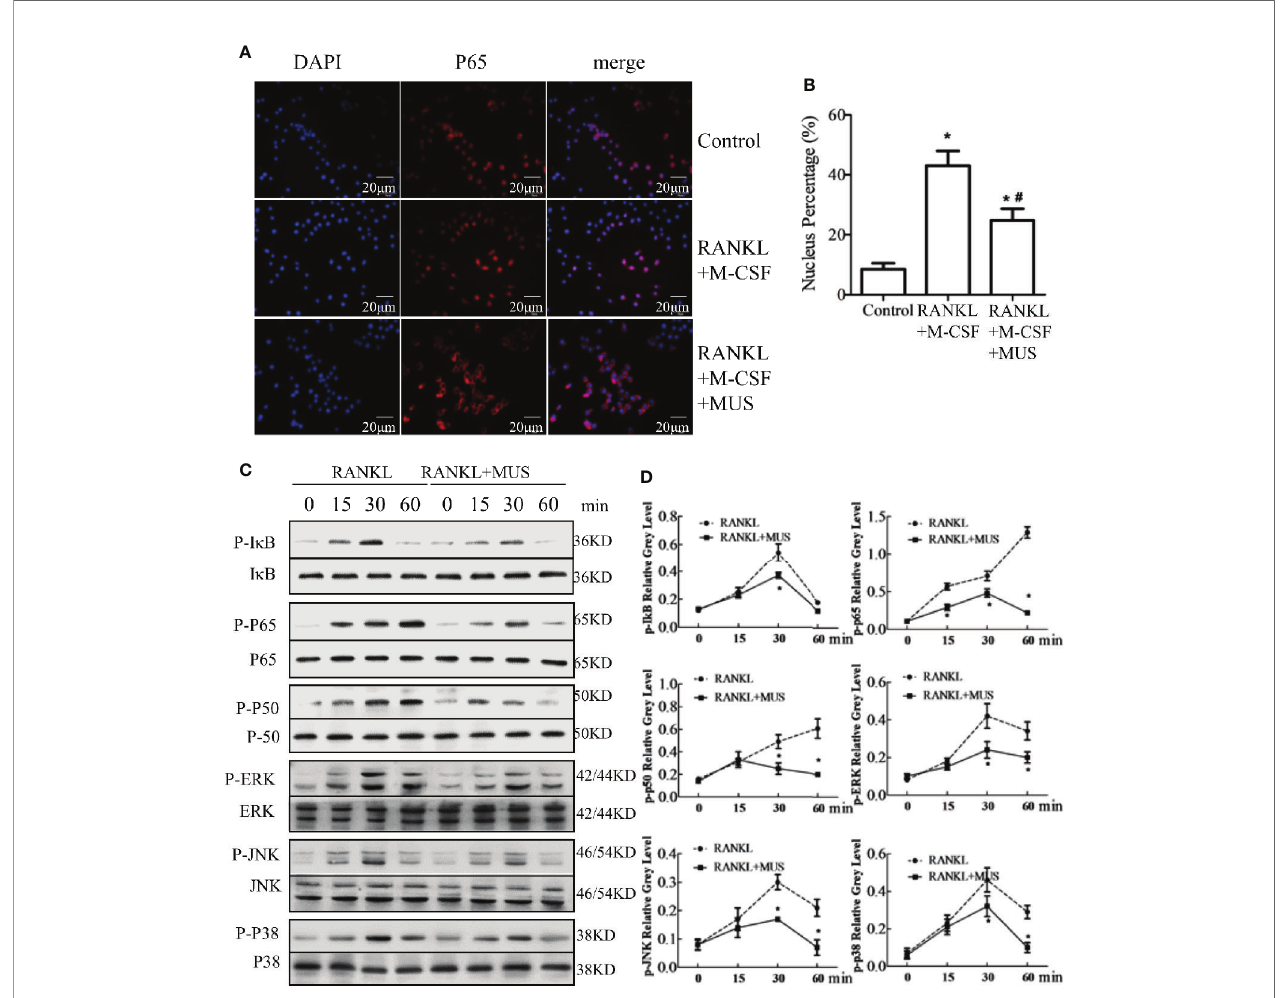
FIGURE 5 | Muscone suppresses RANKL-induced signaling pathways in osteoclastogenesis. (A, B) Immuno fl uorescence staining shows that muscone inhibits RANKL-induced P65 nuclear translocation. (C, D) Muscone suppresses phosphorylation of factors in the NF-kB pathway, including P65, P50, and IkB protein. And muscone also blocks phosphorylation of factors in the MAPK pathways in osteoclastogenesis, including ERK, JNK, and P38. *P < 0.05 vs. the control group, #P < 0.05 vs. the RANKL-induced